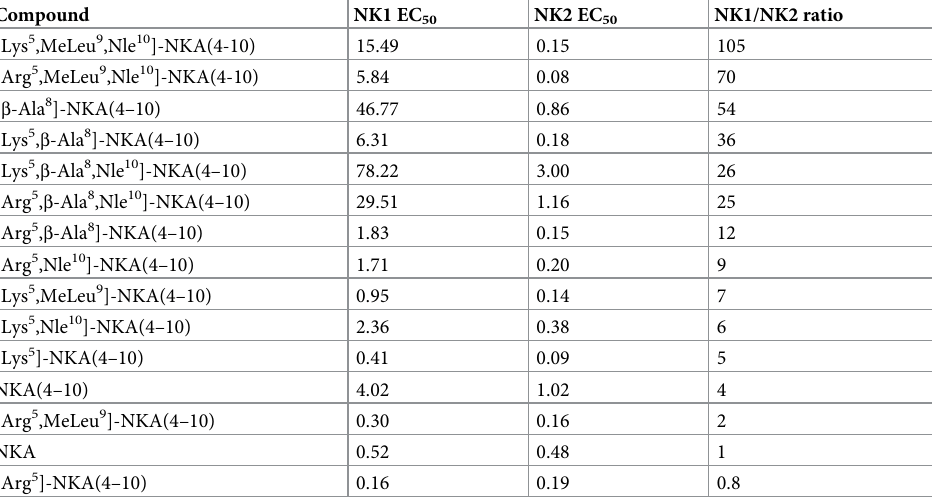
Table 5. Ratio of EC 50 s (in nM) for intracellular calcium response.